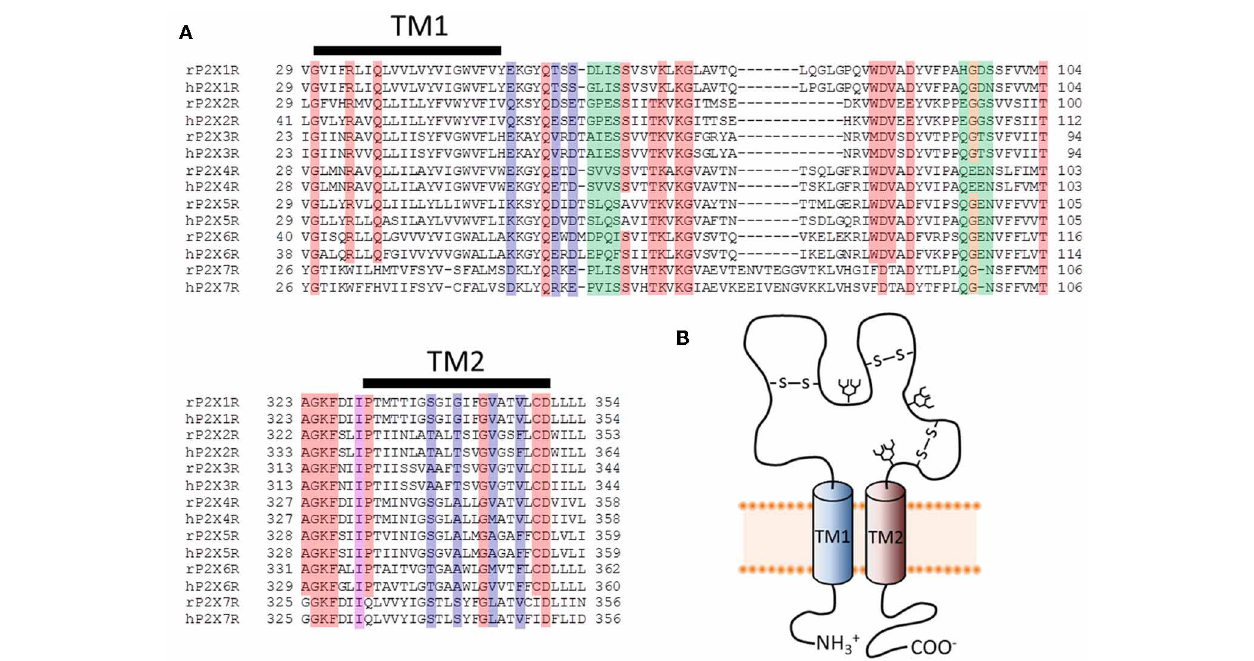
FIGURE 1 | Primary structure of putative pore-forming domains of P2XR subunits. (A) Sequence alignments for select stretches of P2XR subunit polypeptides that include the two transmembrane domains (TM1 and TM2). Both human and rat forms of the P2XRs are shown. Red, orange, and purple boxes indicate highly conserved amino acids that appear in at least six of the seven P2XRs. Blue and purple boxes indicate amino acids likely to form the